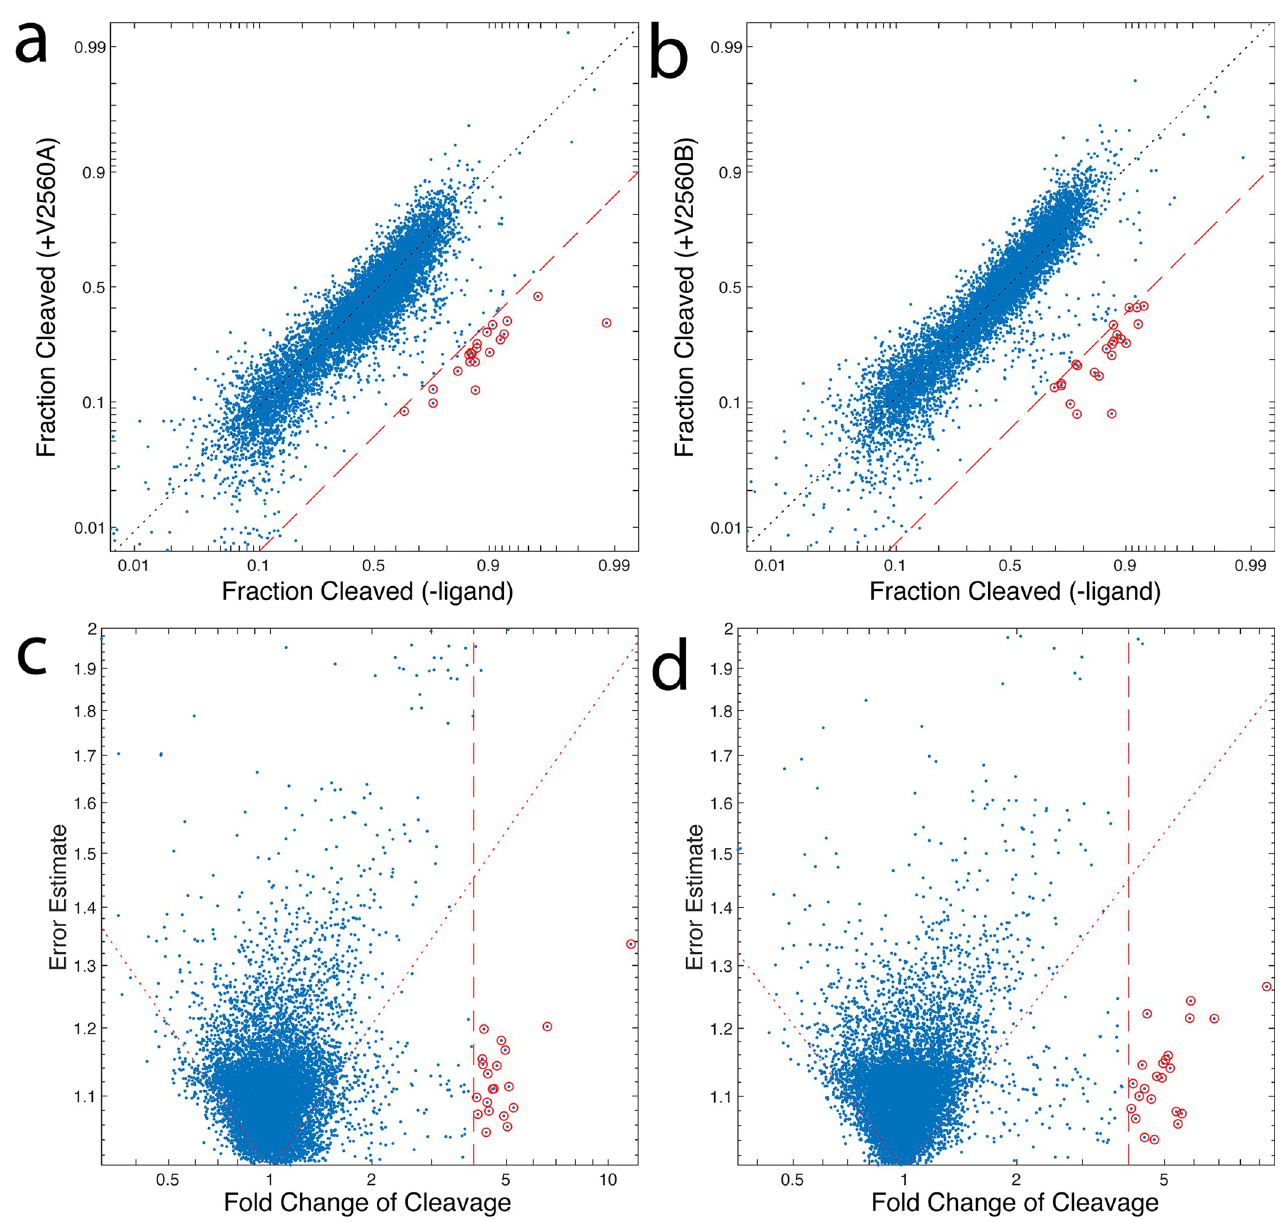
Fig 2. Identification of statistically significant and high fold-chance of cleavage biosensor hits from DRIVER 5120. Comparison of cleavage fractions for products of round 95 with and without target mixtures as determined using CleaveSeq. Left panels (a,c) show the response of each sequence to mixture V2560A and the right panels (b,d) to mixture V2560B. (N ~ 10000 sequences, at least 100 reads/sequence in each analysis). The top panels (a,b) show the cleavage of each measured sensor in each condition and the bottom panels (c,d) show the standard error of the cleaved:uncleaved read count ratio vs. the fold change of cleavage. Significant (two-sided test with Bonferroni correction: p < 1/N) outliers are shown with red circles. Red dashed lines delineate 4-fold change of cleavage. Dotted red lines in bottom panels show the threshold of significance (p =